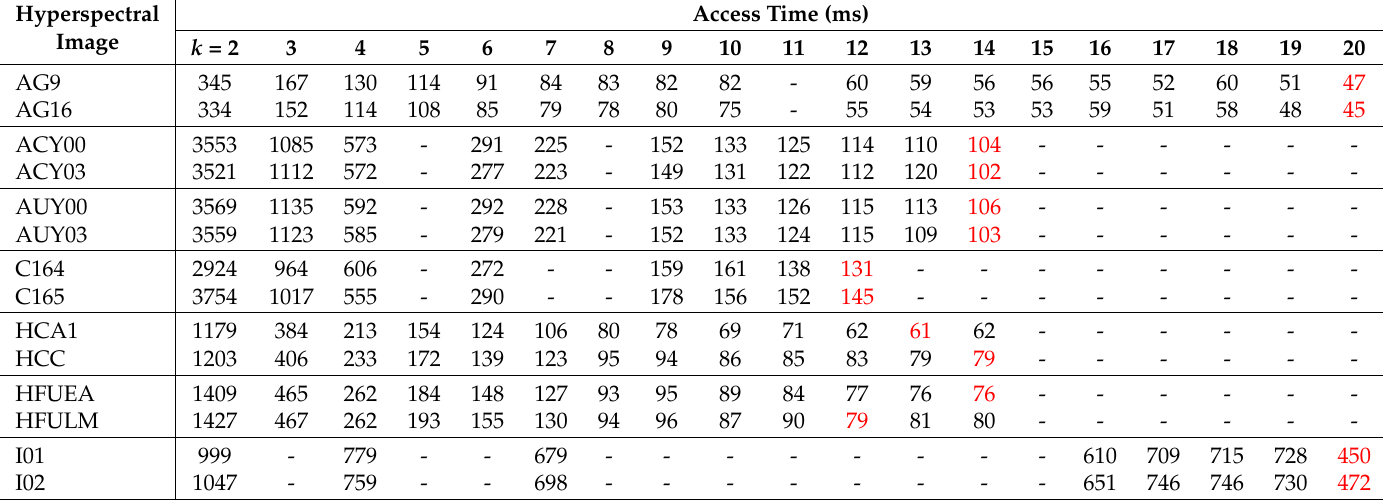
Table 6. Access time (ms) for different k -values for some of the testing images. The best access time is in